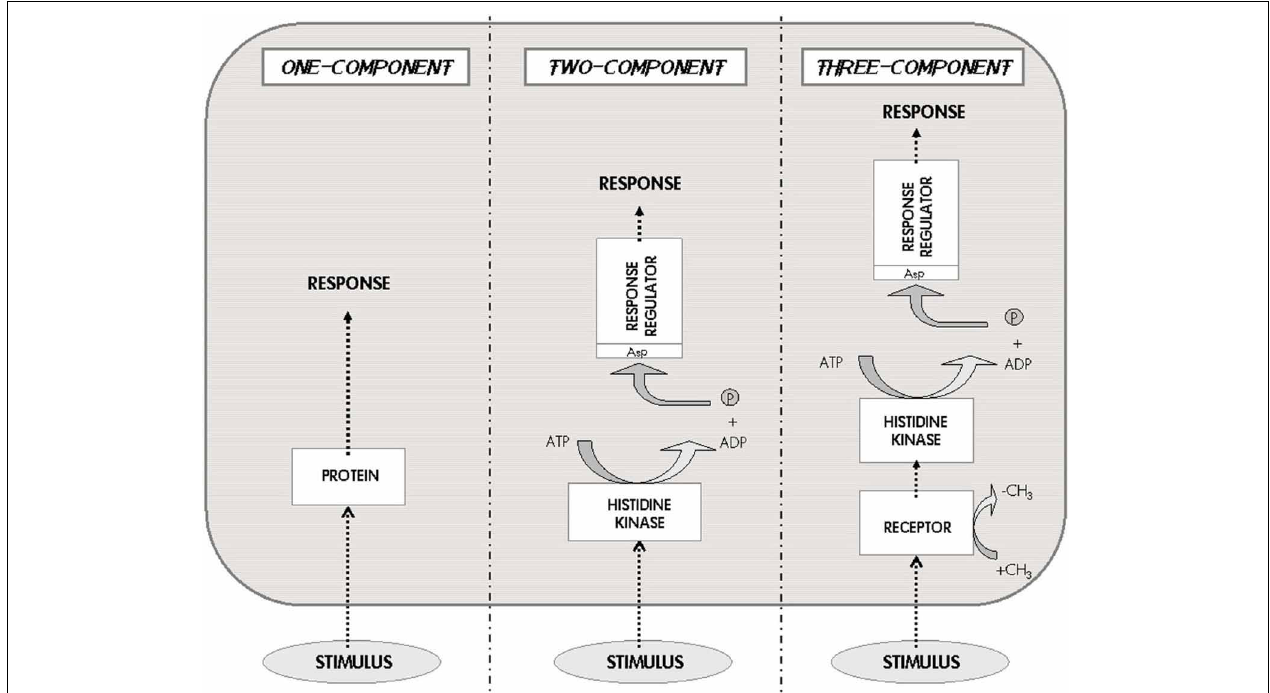
FIGURE 3 | The one-two-three Component Systems. These three systems are the characteristic classes of signaling pathways developed by prokaryotes. The external stimulus is perceived either by an internal receptor–transducer (left), or by a transmembrane histidine kinase that connects with a response